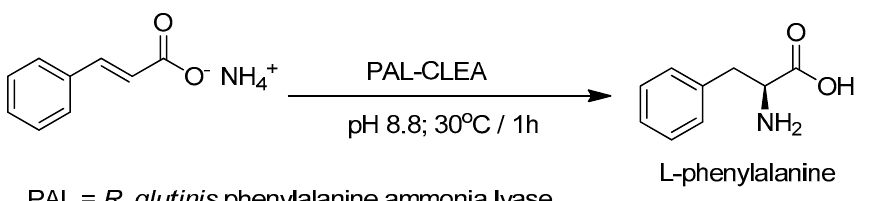
Figure 6. Phenylalanine ammonia lyase (PAL)-CLEA catalyzed synthesis of L -phenylalanine.